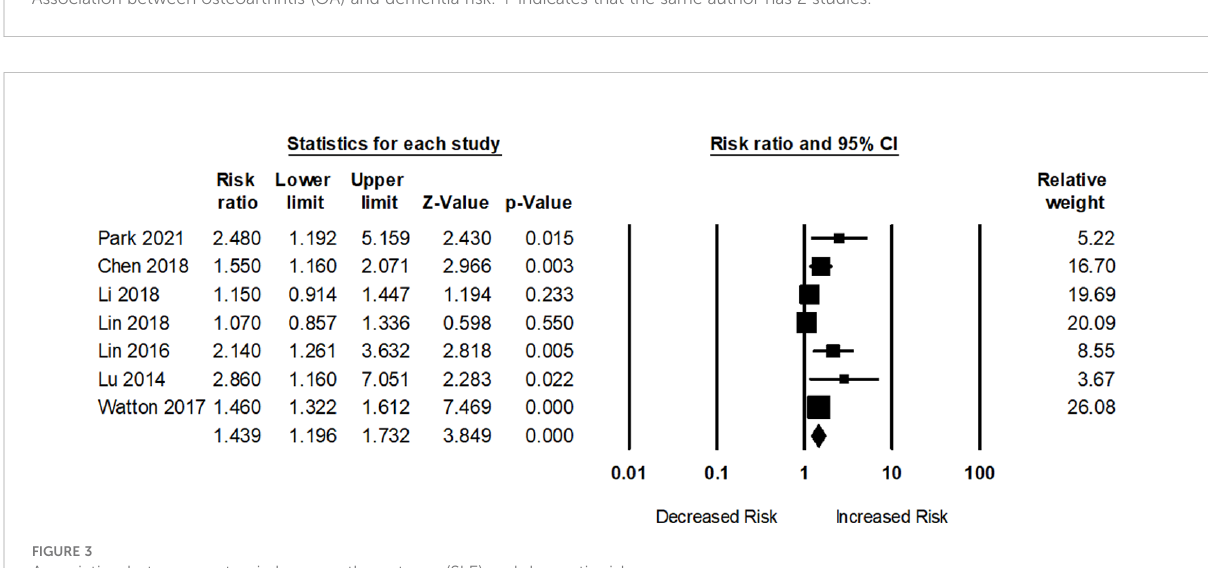
FIGURE 2 Association between osteoarthritis (OA) and dementia risk. + indicates that the same author has 2 studies.